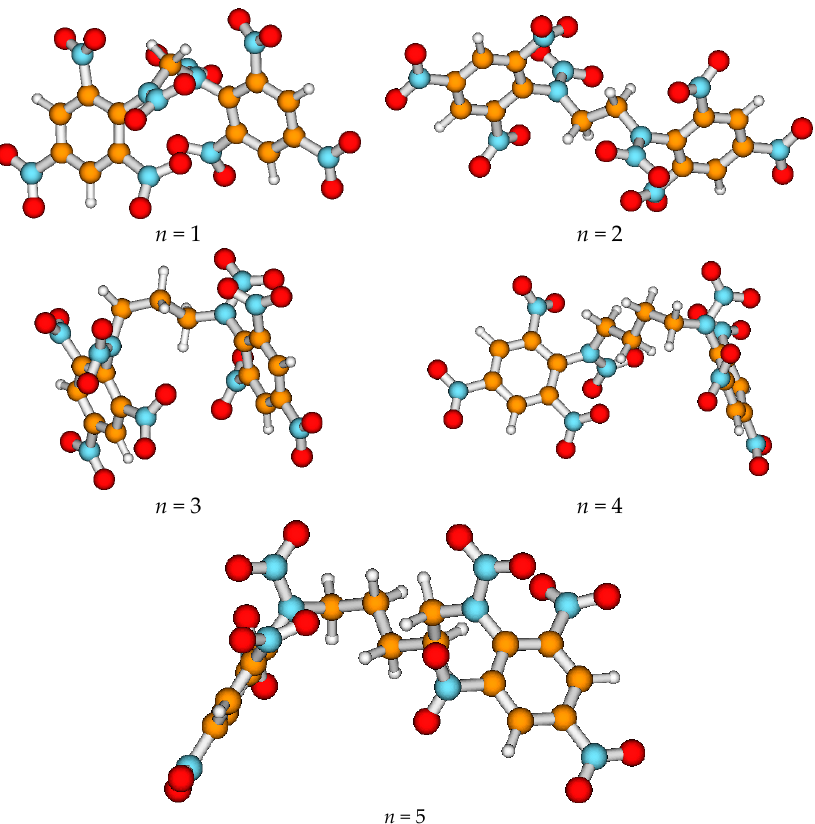
Figure 1. Views of the most stable conformers of bis-aromatic homologs of chain length variation (CH 2 ) n ( n = 1–5) of (b) [(2,4,6-trinitrophenyl-N(NO 2 )] 2 (CH 2 ) n ]. The Figure was drawn by Molden [86].